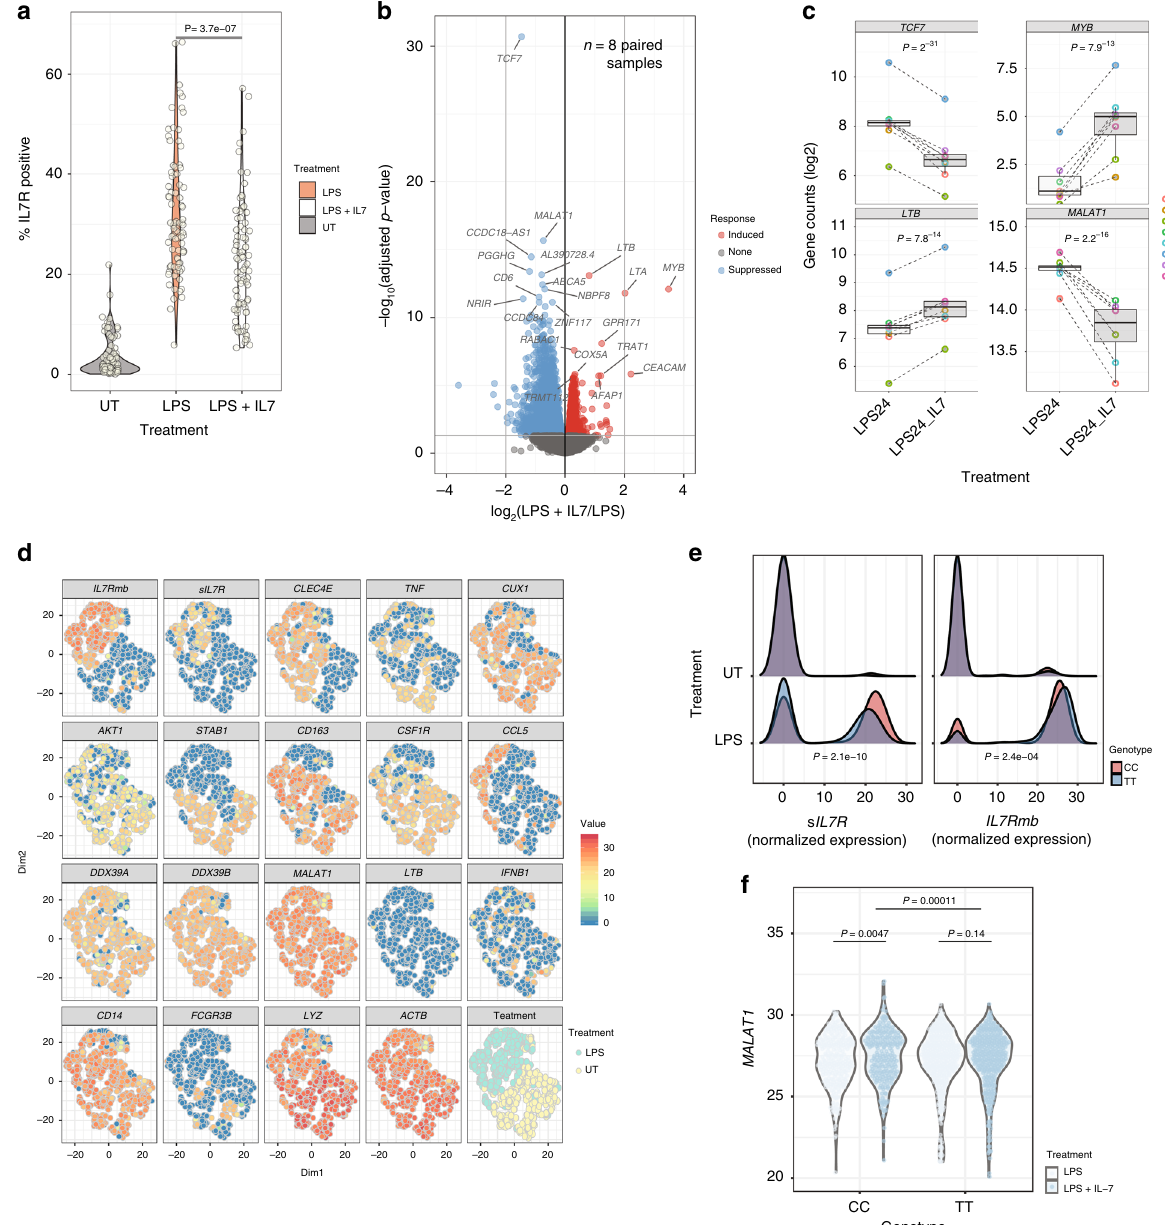
Fig. 4 Monocyte surface IL7R is functional, activating multiple transcriptional pathways. a Violin plot demonstrating monocytes from PBMC cultures in the untreated state, after exposure to LPS and after exposure to LPS with recombinant IL-7. IL-7 leads to marked downregulation of IL7R on LPS stimulated monocytes, indicative sensitivity to exogenous cytokine (paired t -test). b Volcano plot of mRNA from RNAseq experiments of 8 paired monocyte samples either treated with LPS alone for 24 h or with LPS with additional IL-7 added for the last 2 h of culture. Treatment leads to widespread differential transcript expression with the most signi fi cant 20 transcripts labelled. c Example boxplots of genes differentially regulated by recombinant IL-7 in monocytes (linear model). d t-SNE plot of single-cell real-time quantitative PCR (RT-qPCR) data from 10 individuals (1218 cells) either untreated or in the presence LPS showing expression of membrane-bound IL7R ( IL7R mb), soluble IL7R (s IL7R ), CLEC4E, TNF, CUX1, AKT1, STAB1, CD163, CSF1R, CCL5, DDX39A, DDX39B, MALAT1, LTB, IFNB1, CD14, FCGR3B, LYZ, and ACTB . e Density plots of single-cell RT-qPCR expression of sIL7R and mbIL7R normalized expression in untreated and LPS treated monocytes according to rs6897932 genotype. Kolmogorov Smirnov test. f Violin plots of single-cell RT-qPCR expression of MALAT1 in LPS stimulated monocytes either alone or in the presence of recombinant human IL-7 according to rs6897932 genotype, t